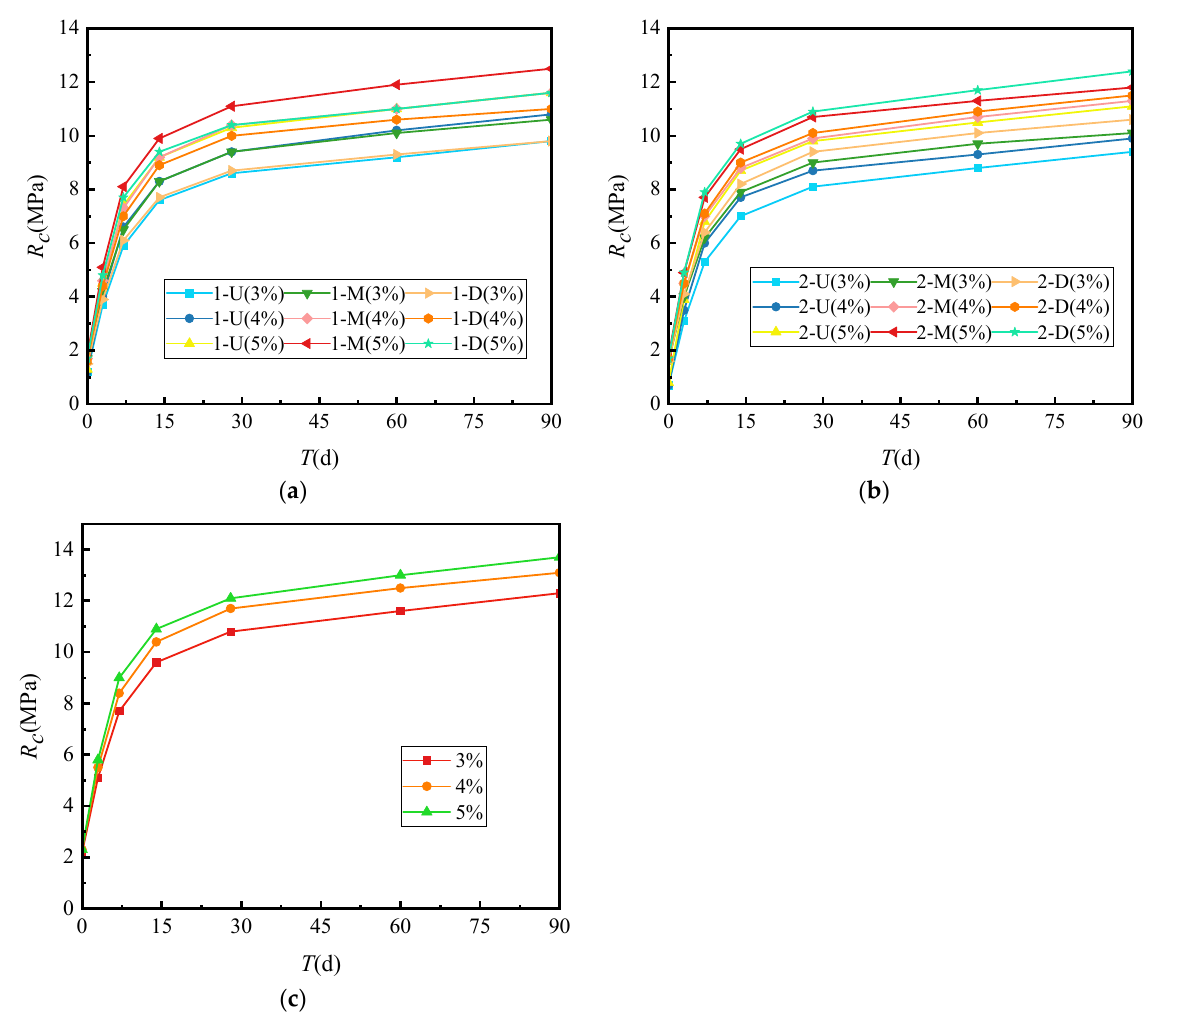
Figure 2. Growth law of unconfined compressive strength. ( a ) GF1, ( b ) GF2, ( c ) VGM-3.